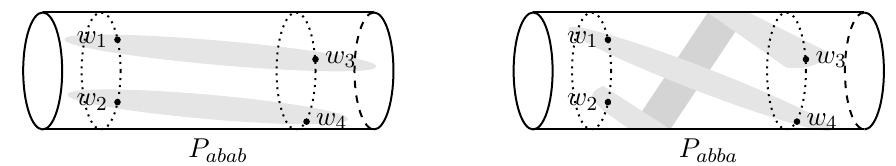
Figure 2 . FK cluster con(cid:12)gurations that contribute to the correlation functions P abab and P abba . (cid:15) The values of the extrapolated amplitudes A | see (4.15)|as well as those of (cid:8) (cid:1)(cid:22)(cid:1) the (cid:12)rst few (in practice, a handful) subdominant contributions to each conformal tower, extracted via the method outlined in section 4.3 are in (cid:12)ne agreement with their exact CFT values in three exactly solvable cases ( Q = 0 ; 2 ; 4), which are treated respectively in appendices B.4, B.2 and B.3. In the most favourable cases the relative deviations are as small as 10 (cid:0) 4